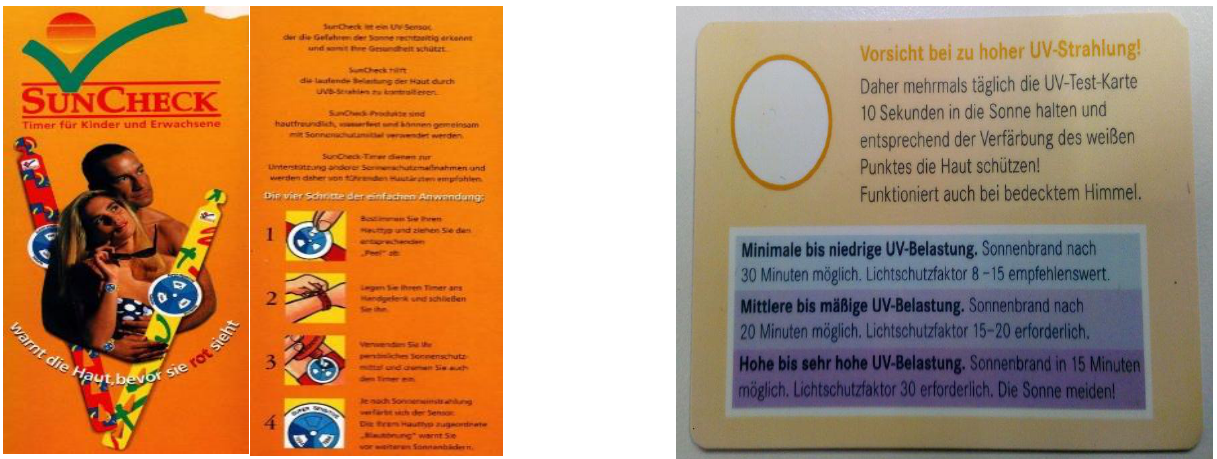
Figure 5. Miniature electronic personal irradiance meter of type SunSaver.